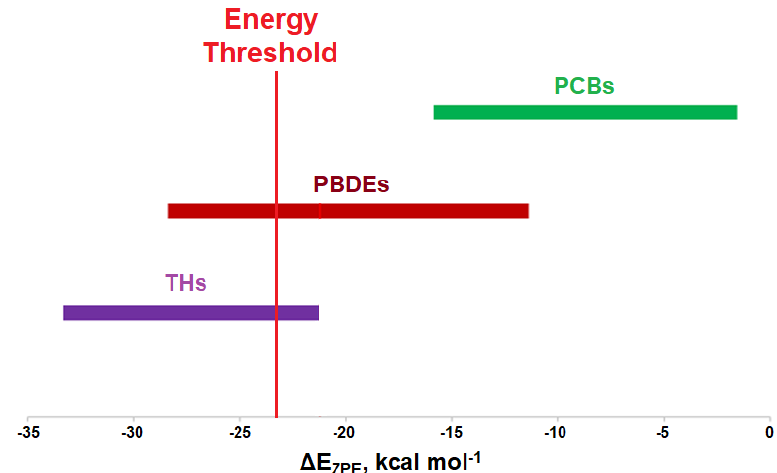
Figure 9. Comparison of XB interactions of THs, PBDEs, and PCBs. The red line indicates a proposed energy threshold needed for dehalogenation, based upon the interaction energy for 3-T 1 .